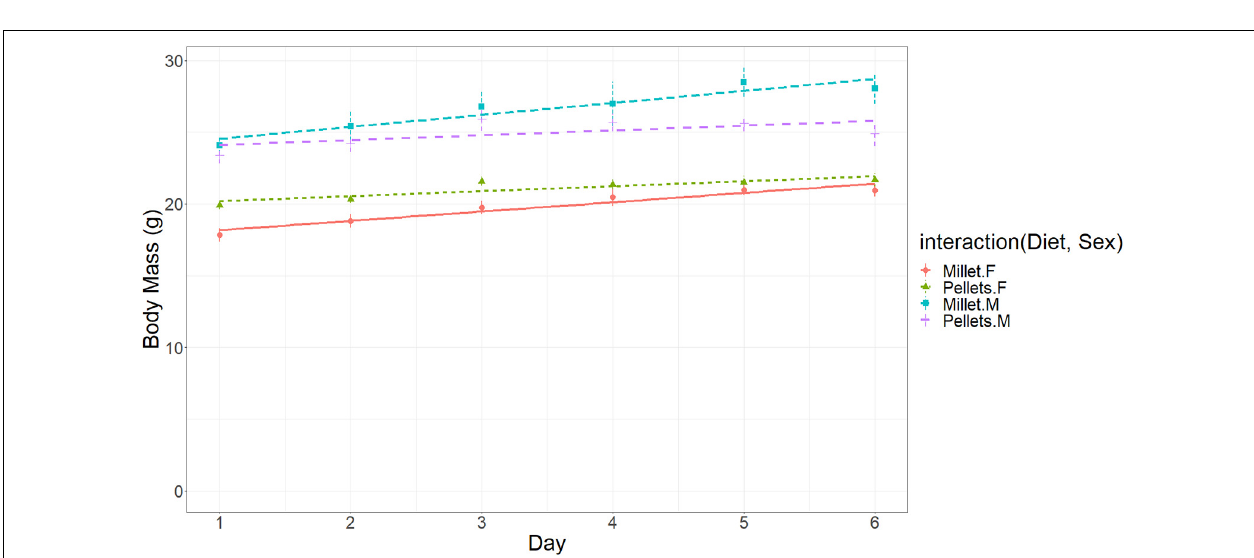
FIGURE 7 | Body mass (g) of the mice in the diet experiment for cancer mice fed a diet of either Millet or Mouse Chow Pellets. Error bars represent standard errors of the means.